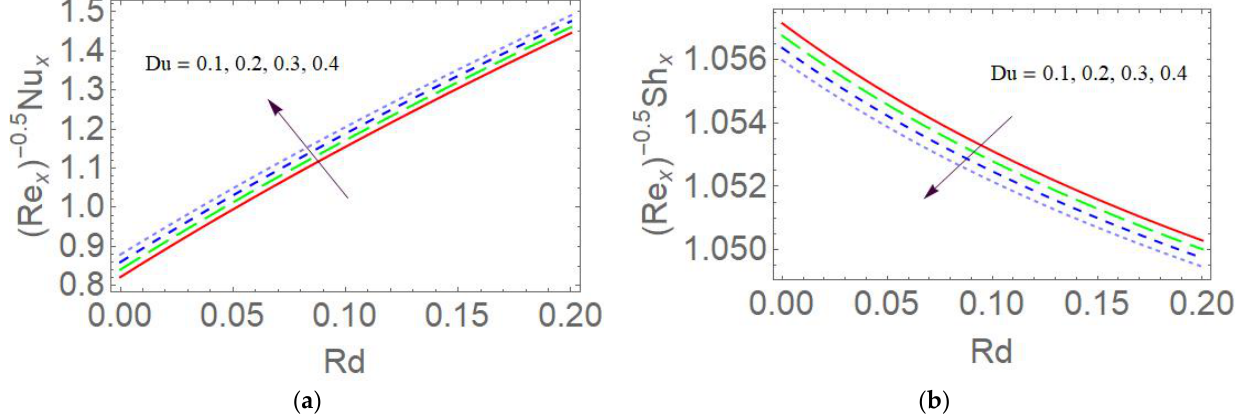
and ( b ) Du on . Figure 9. Impacts of ( a ) Du on Figure 9. Impacts of ( a ) Du on Nu x ( Re x ) − 0.5 and ( b ) Du on Sh x ( Re x ) − 0.5 . −0 . 5 −0 . 5 As shown in Figure 6a–c, increasing the value of α causes C f to increase, but Nu x and 𝑁𝑁𝑁𝑁 𝑥𝑥 ( 𝑅𝑅𝑅𝑅 𝑥𝑥 ) 𝑆𝑆ℎ 𝑥𝑥 ( 𝑅𝑅𝑅𝑅 𝑥𝑥 ) , , and number values computed for various physical Table 4. parameters. 0 . 5 −0 . 5 −0 . 5 𝐶𝐶 𝑓𝑓 ( 𝑅𝑅𝑅𝑅 𝑥𝑥 ) 𝑁𝑁𝑁𝑁 𝑥𝑥 ( 𝑅𝑅𝑅𝑅 𝑥𝑥 ) 𝑆𝑆ℎ 𝑥𝑥 ( 𝑅𝑅𝑅𝑅 𝑥𝑥 ) the C f , Nu x , and Sh x numbers decrease sharply, because magnetic fields produce